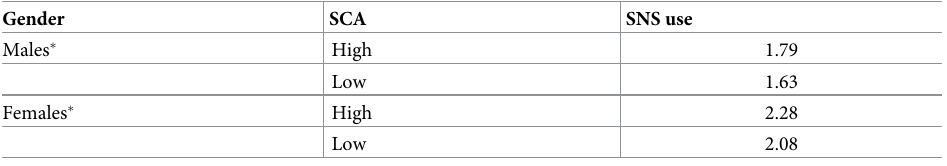
Table 8. Self-centered appearance focused use of social media (SCA) as associated with levels of narcissism and gender.